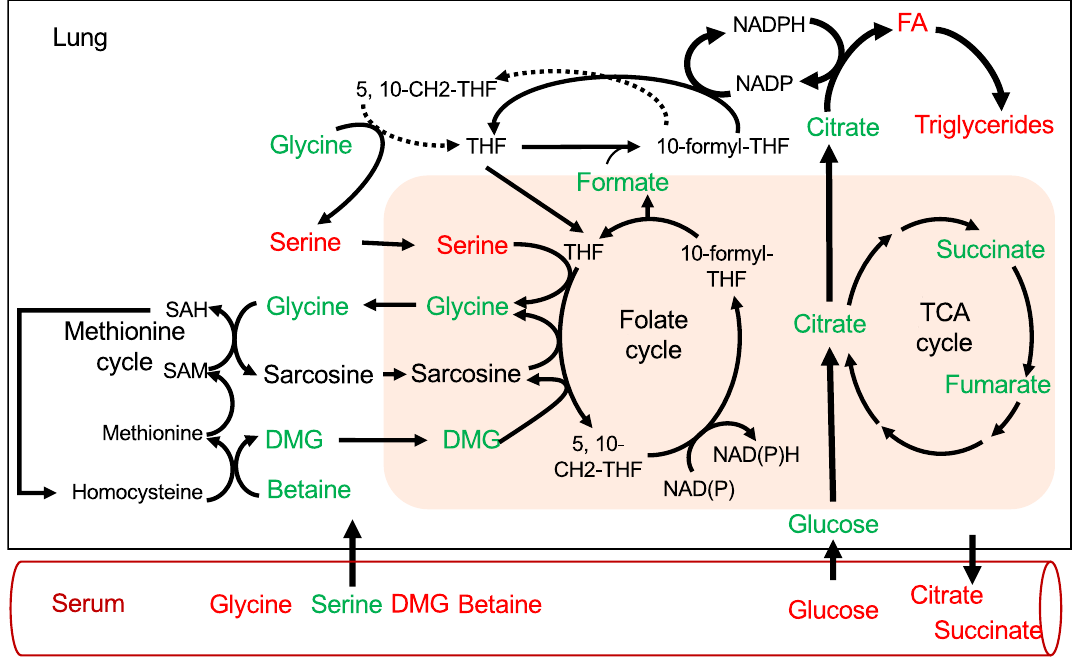
Figure 3. The accumulation of lipids is linked to alterations in the 1C cycle but not to the TCA pathway derived metabolites in the lung of HFHSD mice. Schematic diagram of 1C (methionine plus folate cycles) and TCA cycles, their subcellular compartmentations (mitochondrion in pink) and their potential link with de novo lipogenesis 30,31 . HFHSD causes significant modifications in 1C-derived metabolites in the lung and serum, and a significant modification in TCA-derived metabolites only in serum. Modified metabolites are represented in red, unmodified in green and non-detected in black. 1C-derived metabolites were also altered in other organ and specifically in the liver but were not represented